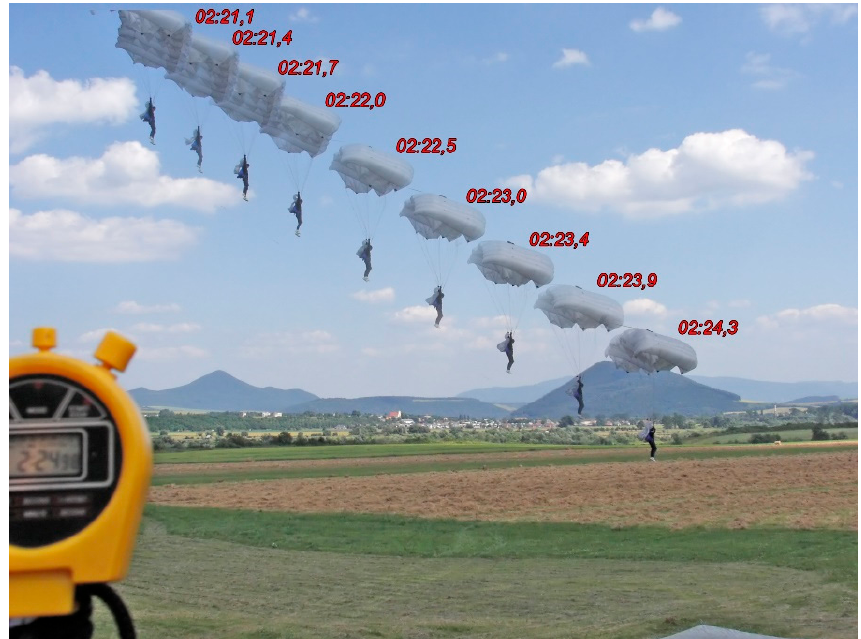
Figure 14. Test jump with parachute M-282 with verification of sequential shooting mode of camera (source: The authors of this article).